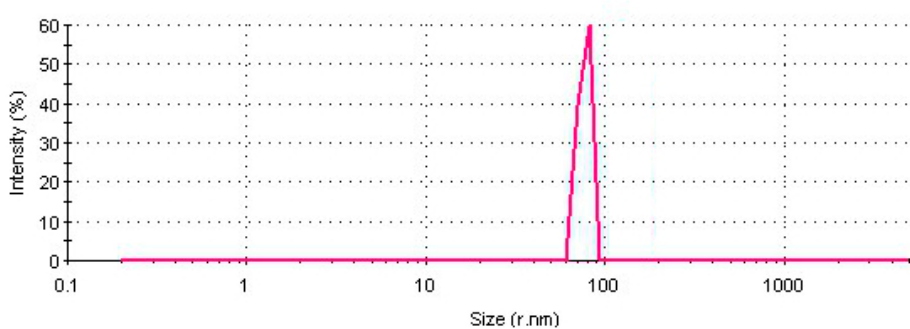
Figure 3. Size distrubition of the LiP nanoparticles.